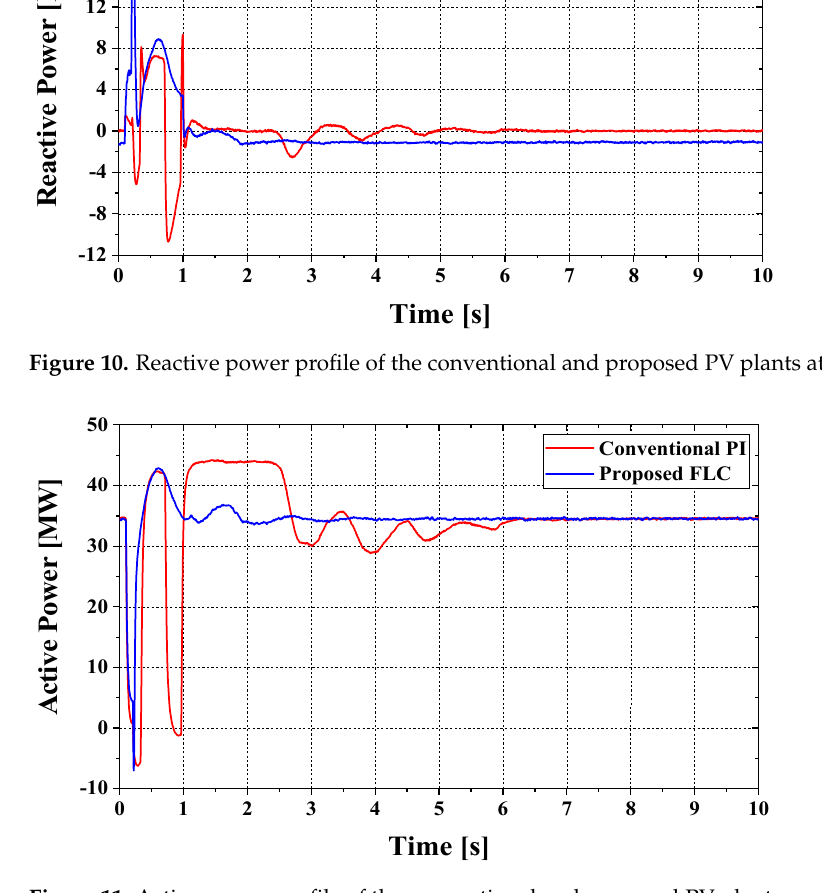
Figure 12. Rotor speed profile of the SGs.